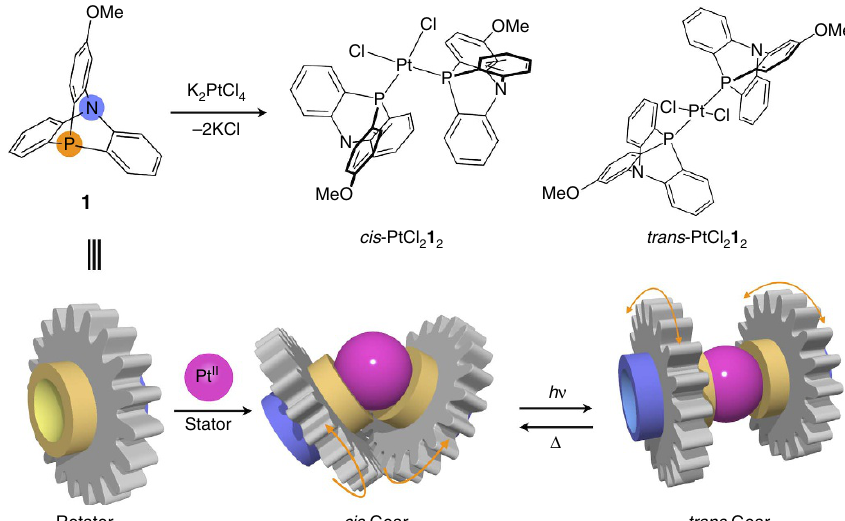
Figure 1 | Schematic representation of a Pt II -centred molecular gear PtCl 2 1 2 . This molecular gear has two azaphosphatriptycene rotators coordinating to the central Pt II ion as a stator. Isomerization between an engaged cis -form and a disengaged trans -form are reversibly driven by ultraviolet irradiation at 360nm and heating.